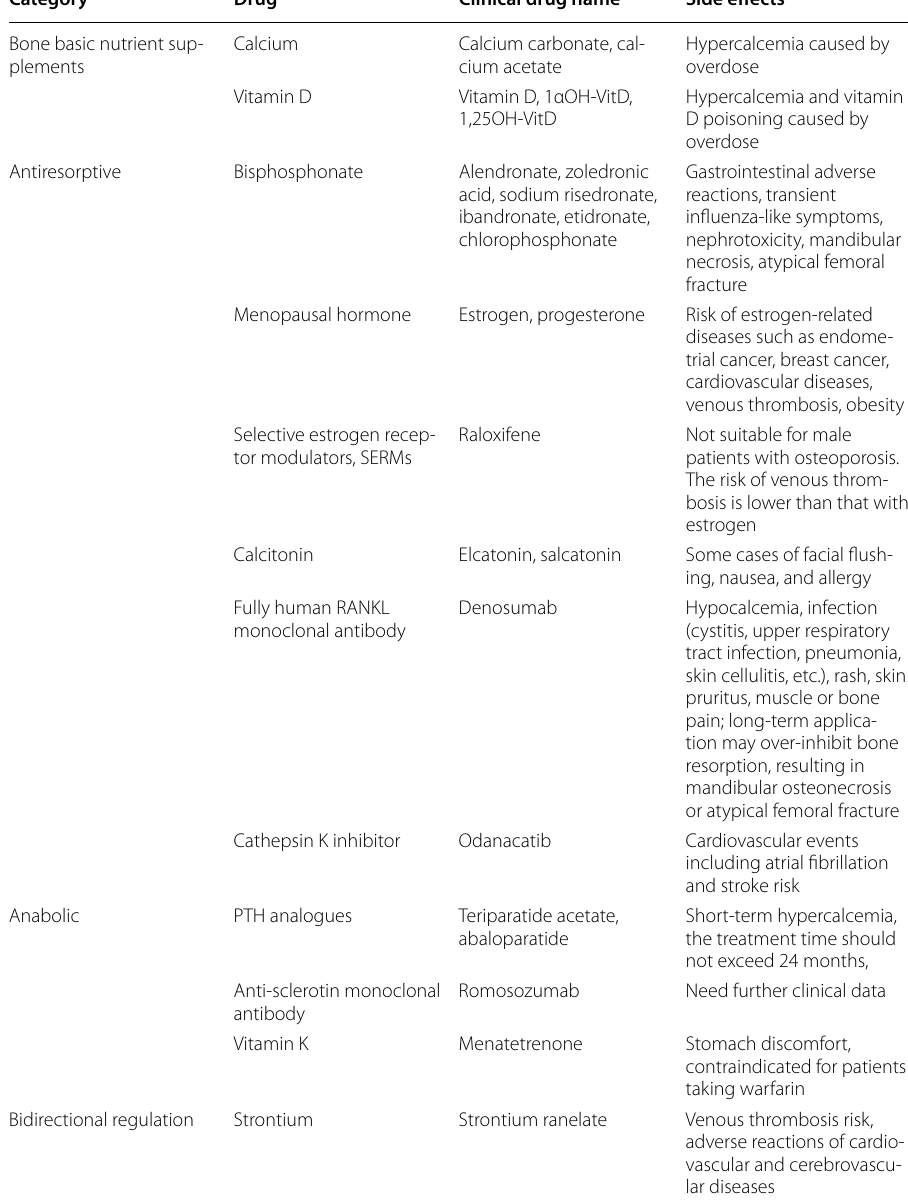
Table 2 Summary of drugs for osteoporosis treatment and their side effects